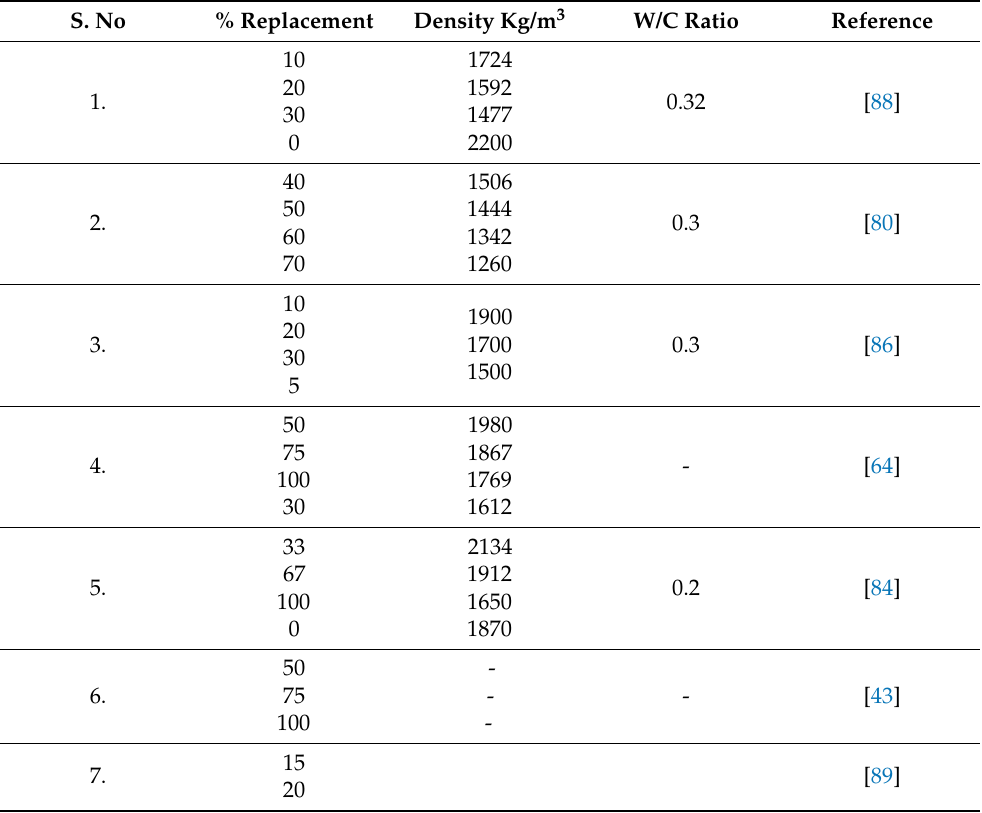
Table 1. Percentage replacement by cenospheres in the